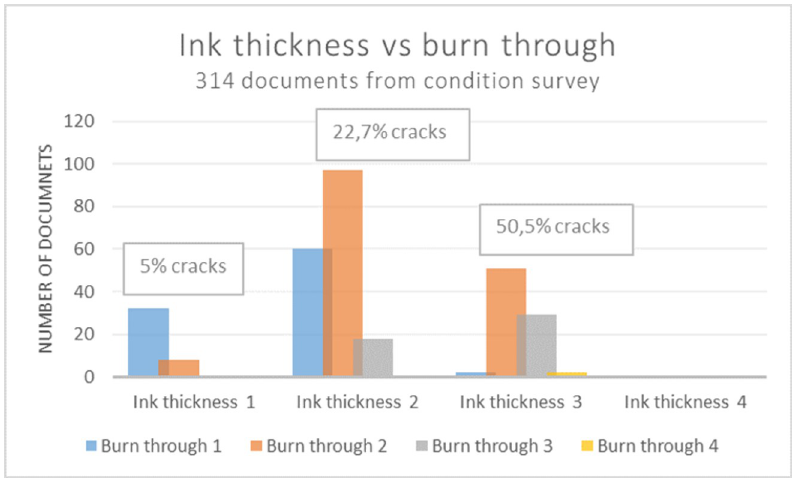
Fig 16. Burn through in relation to ink thickness and occurrence of cracks as assessed by the condition survey. Y- axis displaying number of documents of specified level of overall ink thickness, 1–4, and burn through, 1–4. Inserted boxes present occurrence of cracks within each category of ink